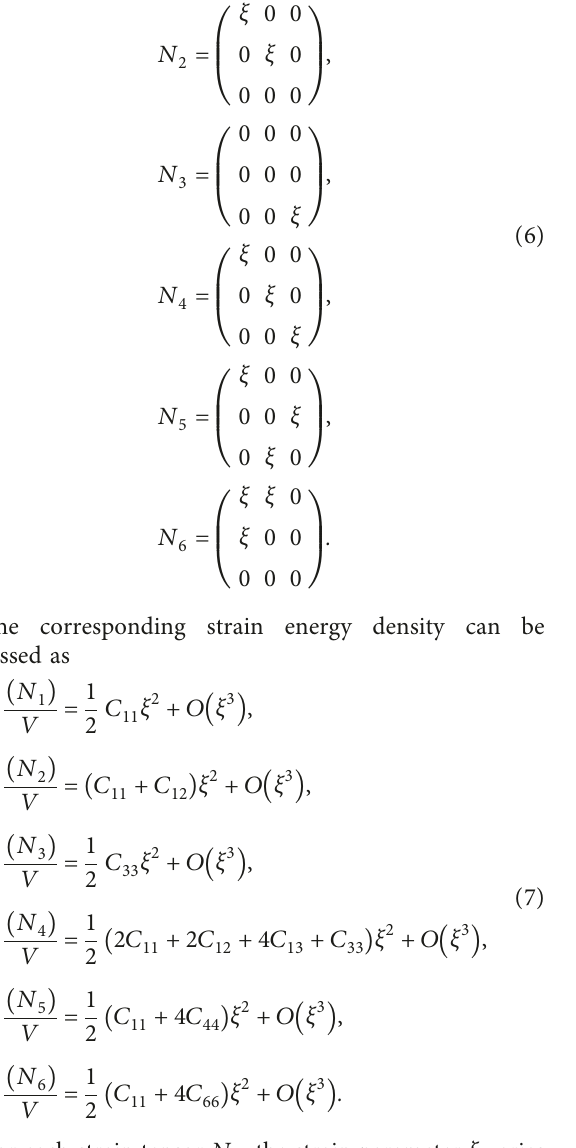
Table 1: Calculated lattice constants ( a and c in ˚A) and primitive cell volume ( V in ˚A 3 ) for tetragonal LiFeAs and NaFeAs under different pressures ( P in GPa) at 0K.